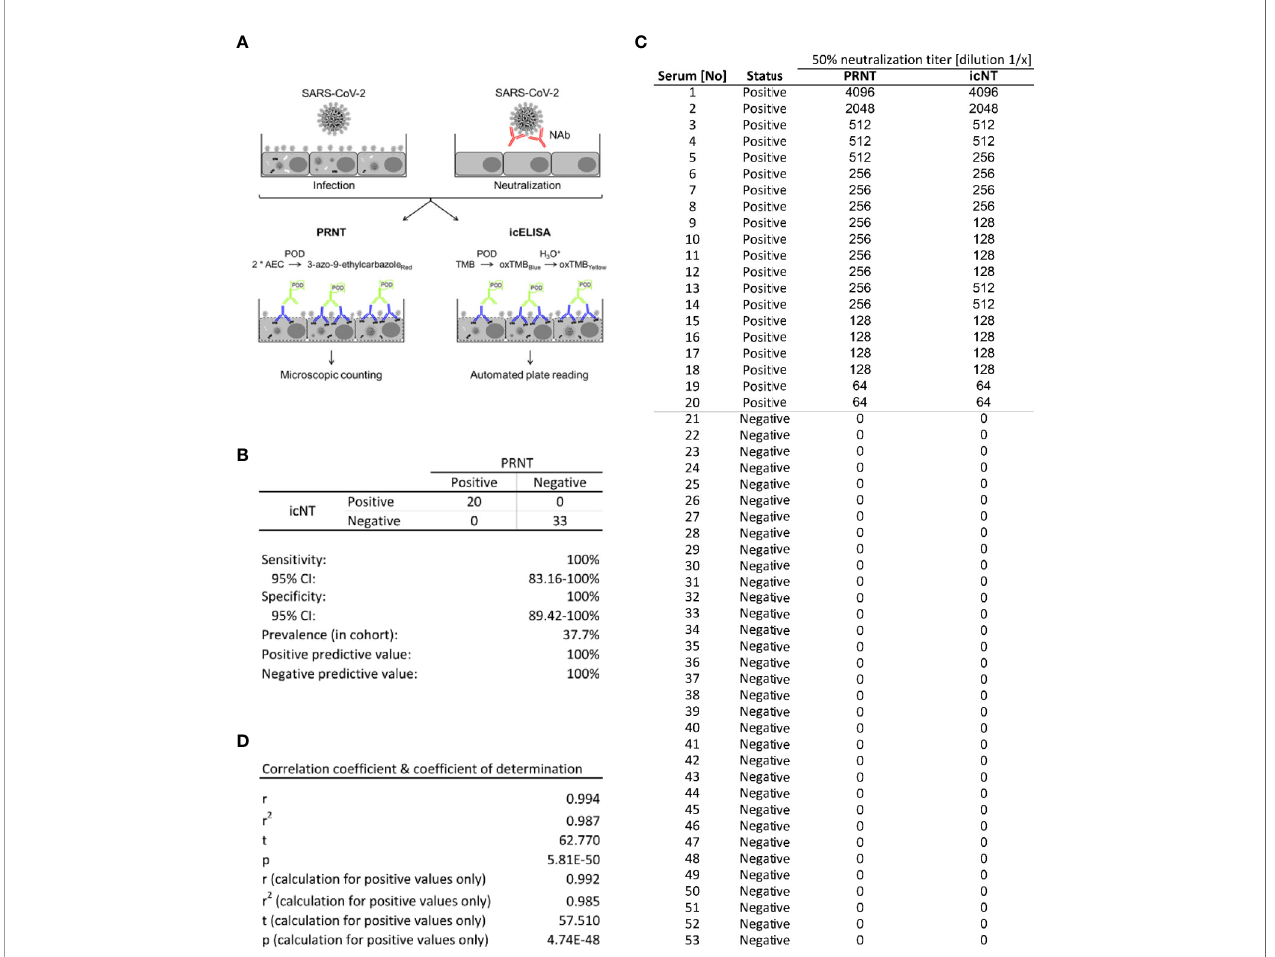
FIGURE 4 | The icNT results correlate with the standard SARS-CoV-2 neutralization test. (A) Schematic representation of AEC stain-based classic NT and icELISA- based icNT. In the upper right panel, the intracellular viral antigens are missing due to the neutralization. NAb, neutralizing antibody. PRNT, plaque reduction neutralization test. POD, peroxidase. AEC, 3-amino-9-ethylcarbazole. TMB, tetramethylbenzidine. (B) Sensitivity and speci fi city calculation of icNT compared to the conventional PRNT. Calculations were performed using algorithms online available at https://www.medcalc.org/calc/diagnostic_test.php. (C) 200 PFU of SARS-CoV- 2 were incubated with different dilutions of serum samples for 1 h before Vero E6 were infected. At 20 and 48 h p.i., neutralizing capacity was evaluated by icELISA and AEC staining with subsequent microscopic counting, respectively. The highest dilution capable to neutralize 50% of input was determined and results of PRNT and icNT were compared. The presence of detectable SARS2 NAbs (column: Status) and the 50% neutralization titers of PRNT and icNT are depicted. (D) Calculation of the correlation coef fi cient (r), the coef fi cient of determination (r 2 ), and the p value for the entire data set shown in (C) (upper part) and the neutralizing samples ( ‘ positive ’ ) only (lower